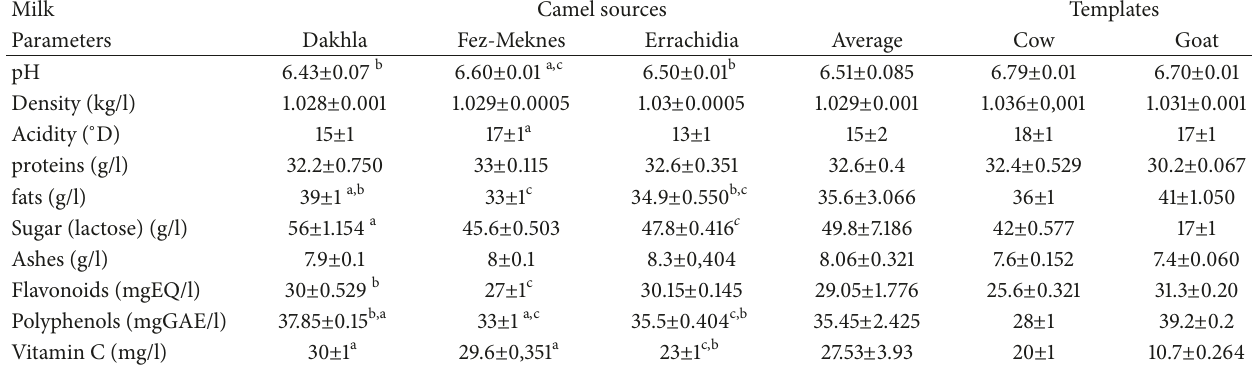
Table 1: Study of camel milk collected from different regions of Morocco and their comparison with goat’s and cow’s milk. Milk Camel sources